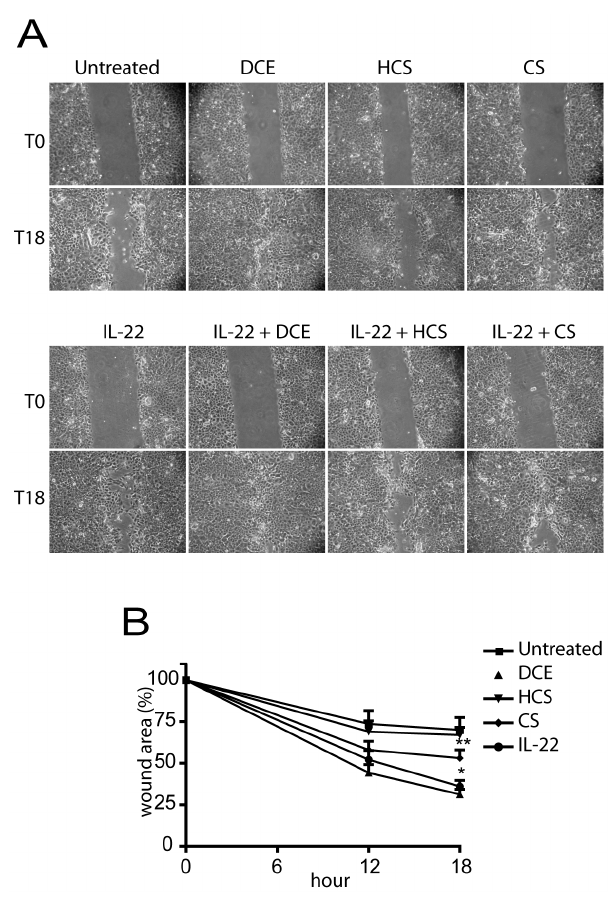
Figure 6. DCE and CS accelerates invitro wound healing by enhancing keratinocyte migration. Scratch assays were carried out on scratched keratinocyte cultures incubated or not with 30 ng/ml IL-22 for 18 h, in presence of DCE, CS or HCS (A). Cultures were also treated with 10 m M mitomycin and stimulated as indicated in B). Residual gap between migrating keratinocytes is expressed as percentage of initial scratched area. * p # 0.01 and ** p # 0.05 vs untreated samples.